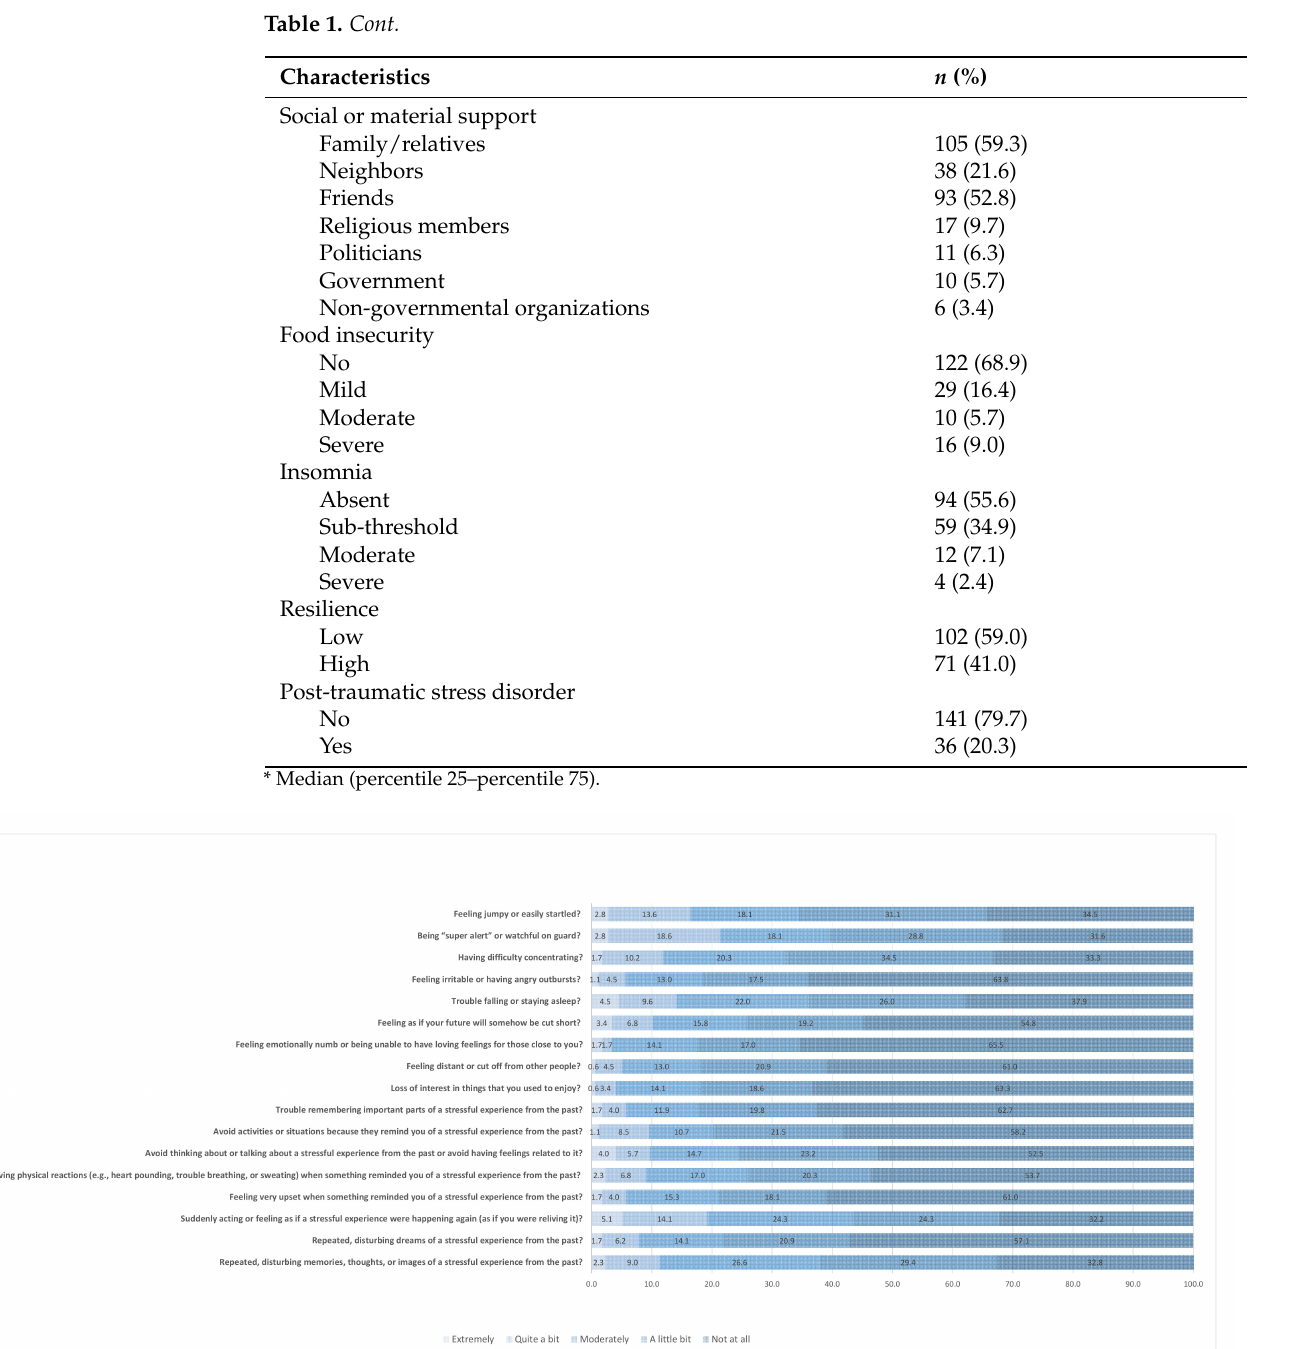
tics. High resilience was associated with a lower frequency of PTSD symptoms (11% high resilience vs. 26% low resilience, p = 0.021). Severe insomnia was associated with a higher prevalence of PTSD symptoms (75% severe insomnia vs. 10% absent insomnia, p < 0.001). Severe food insecurity was associated with a higher frequency of PTSD symptoms (44% severe food insecurity vs. 15% no food insecurity, p <